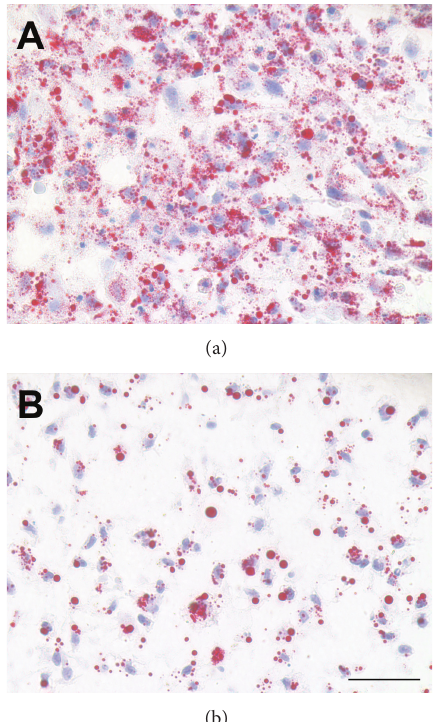
F 3: Adipogenic differentiation of hMSCs in aggregate culture at two weeks, illustrating the loss of adipogenic differentiation potential with serial expansion in culture. e cells in both Figures are from the same donor preparation and were expanded using the identical medium formulation. (a): 2nd passage cells; (b): 10th